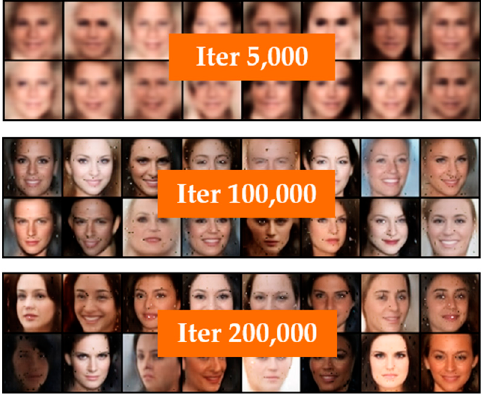
Figure 5. Differences in the generated images when the number of iterations increases.